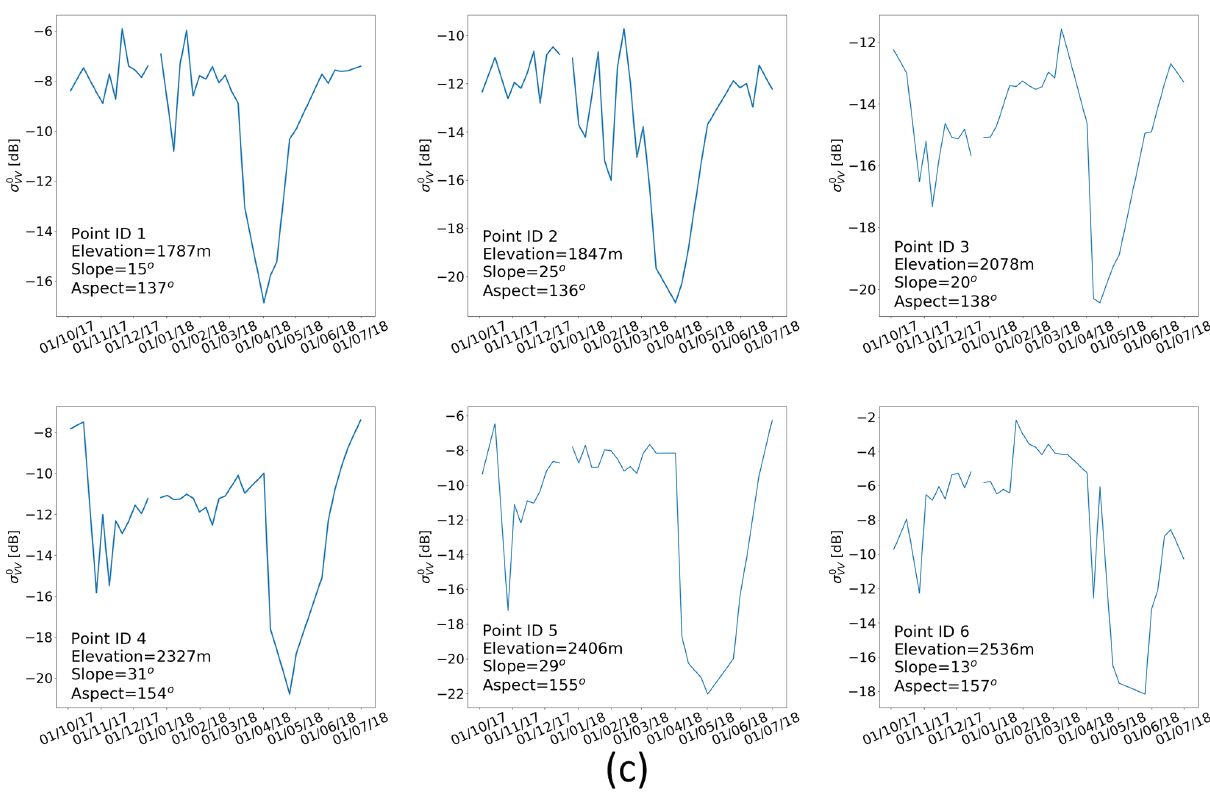
Figure 6. Runoff onset for the Zugspitzplatt catchment. (a) Test site presentation (© 2019 Microsoft Corporation, © 2019 Digital Globe, © CNES (2019) Distribution Airbus DS). (b) Map of the runoff onset (contains modified Copernicus Sentinel data, 2018, processed by Eurac Research). The runoff started at lower altitude and at the south-exposed slopes. The last areas to have the runoff in the catchment are the high-altitude, the north-exposed and glacierized areas. (c) The multitemporal backscattering time series extracted from track T117 for the selected points identified in (b) . All the time series present the characteristic U-shaped